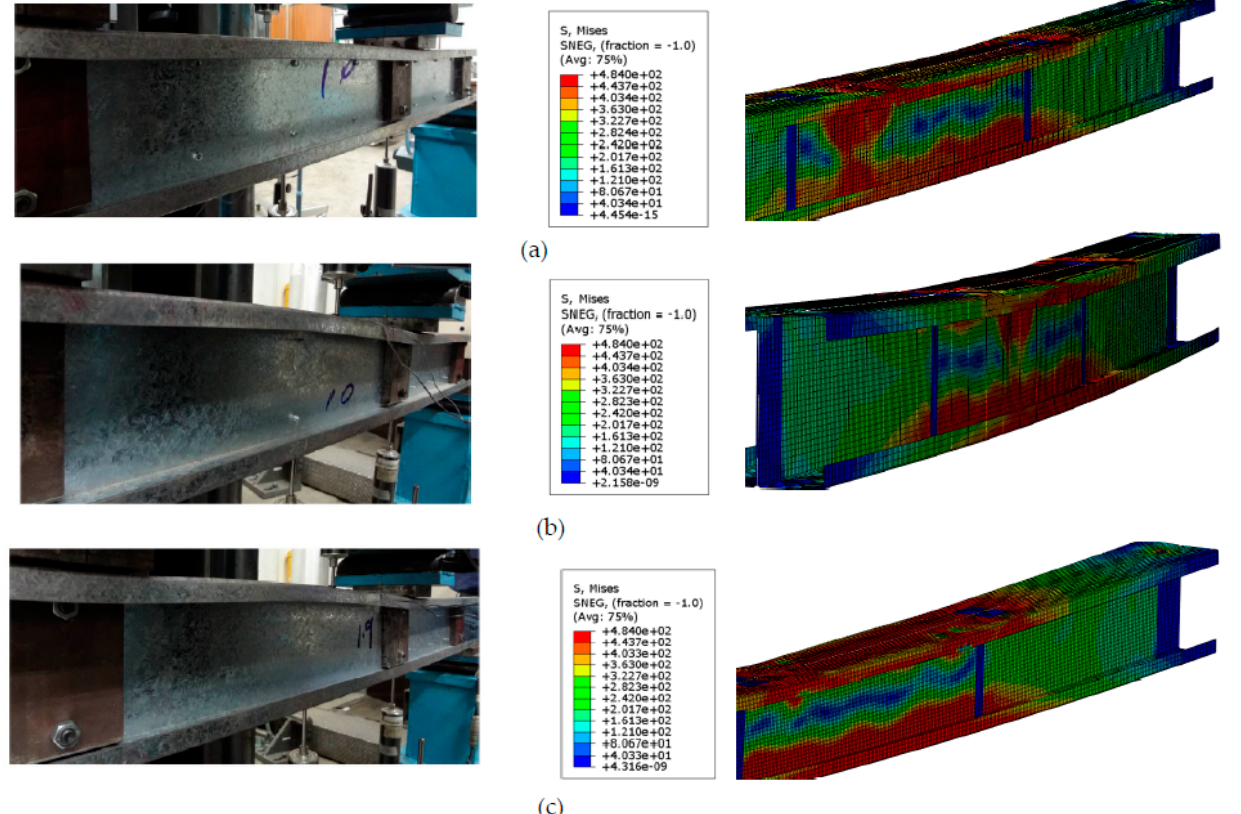
Figure 8. Failure mode comparison for ( a ) OT1.9-136-S150, ( b ) OT1.9-136-S300 and ( c ) OT1.9-136-S600 built-up channel section [13].